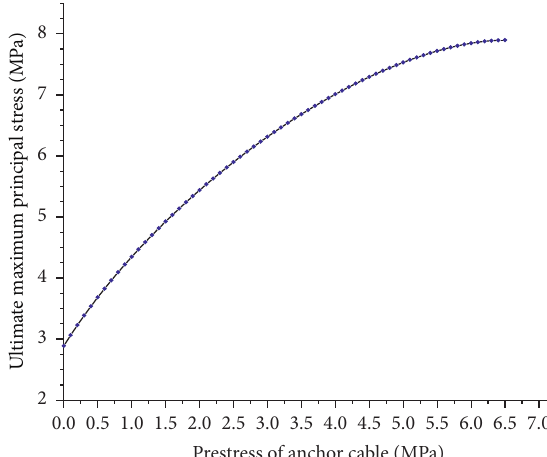
Figure 8: The change of the maximum bearing capacity with the pretension of the anchor cable.